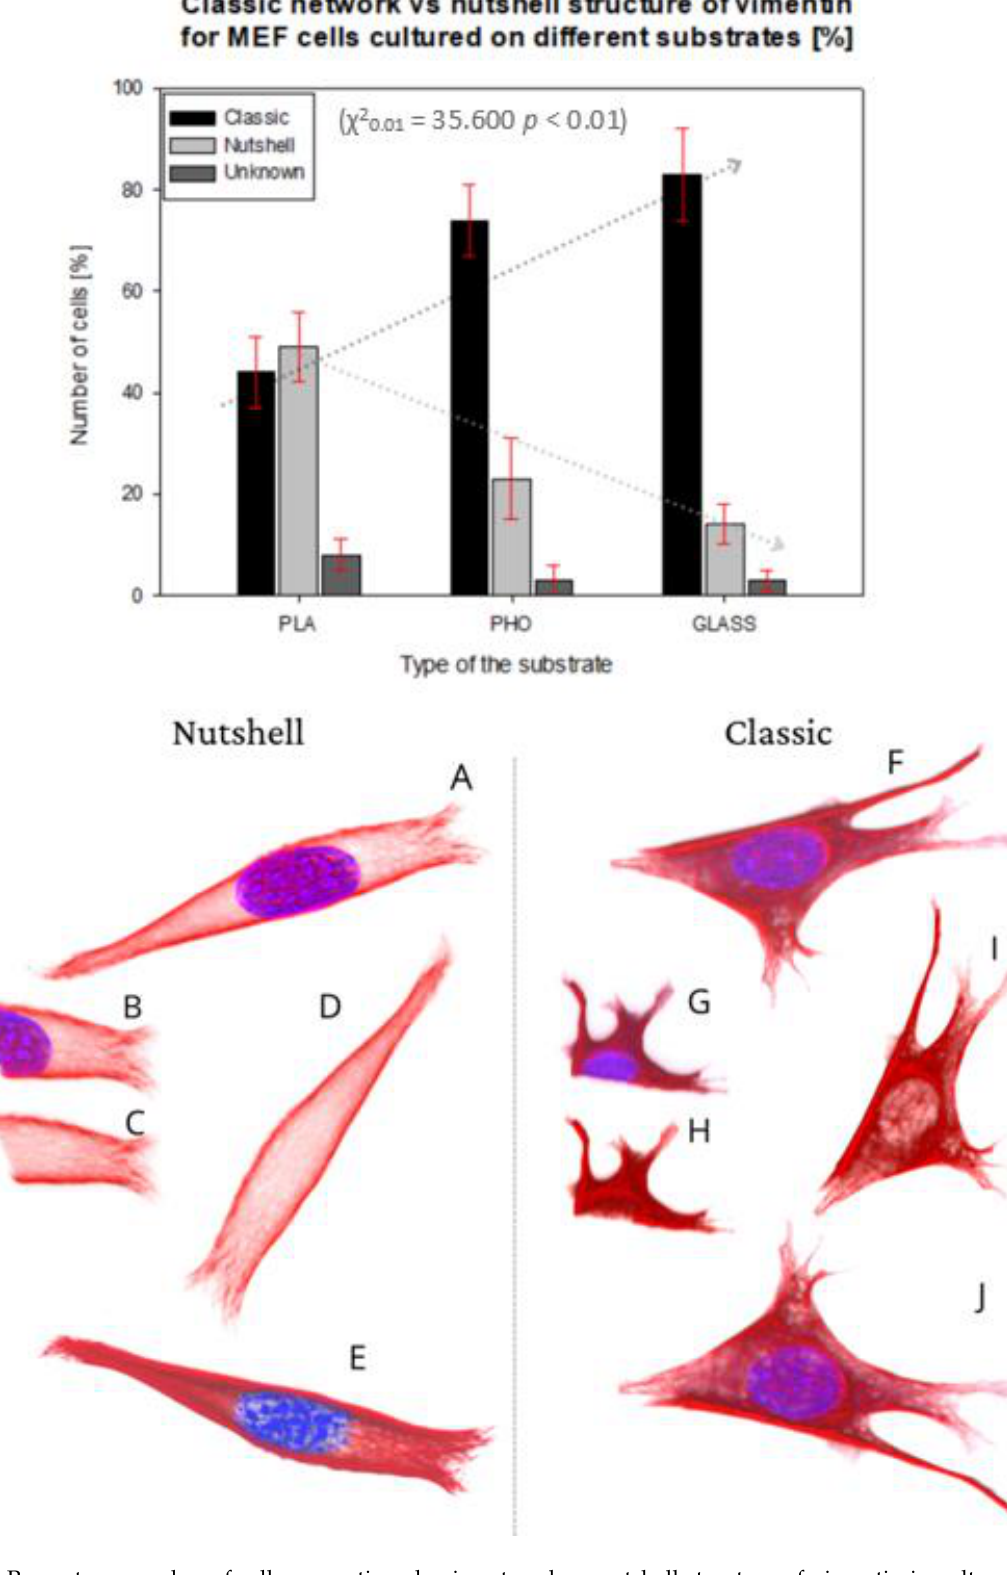
Figure 3. Percentage number of cells presenting classic network or nutshell structure of vimentin in cultures on PLA, P(3HO), and glass. 3D projection of examples of nutshell structure cell ( A – E ), and classic structure cell ( F – J ). Vimentin — Red, Nucleus — Blue. ( B , G ) Fragment of confocal image slice showing the structure of vimentin close to or in the area of the nucleus (( C , H ) DAPI channel not present).